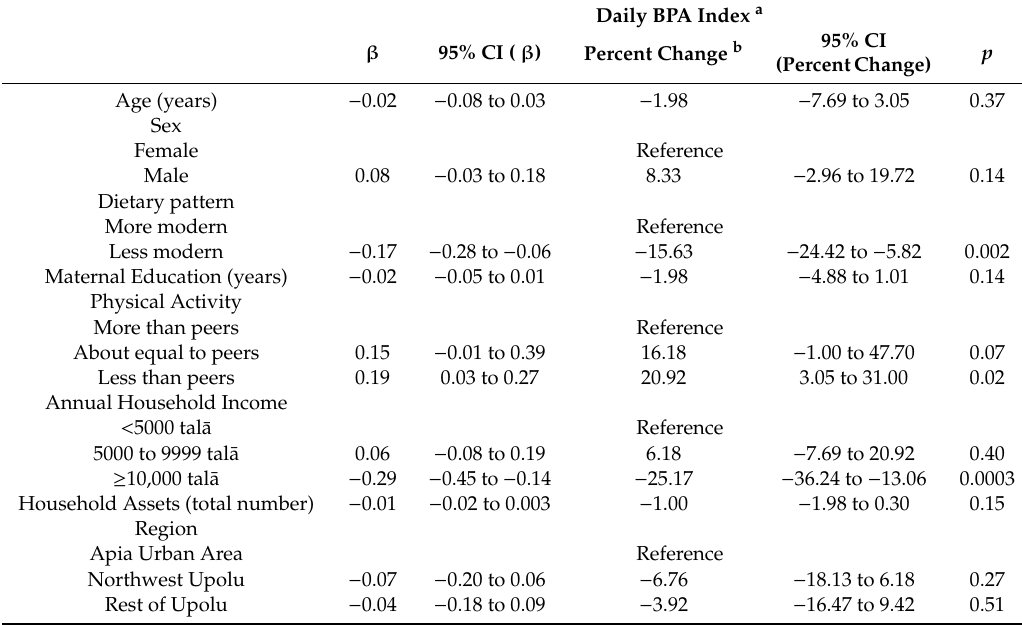
Table 4. Results of multiple linear regression examining associations between participant characteristics and log-transformed (base e) daily BPA index in children ( n =